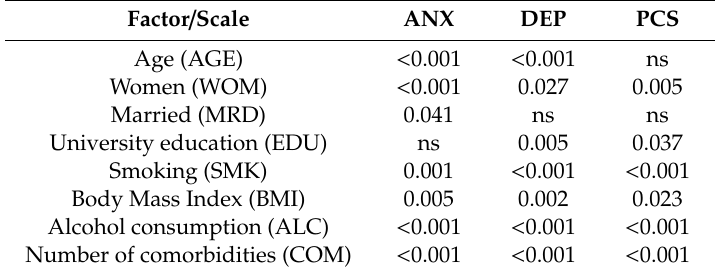
Table 2. E ff ect of sociodemographic factors on anxiety, depression subscales, and pain catastrophizing scale § . Factor /